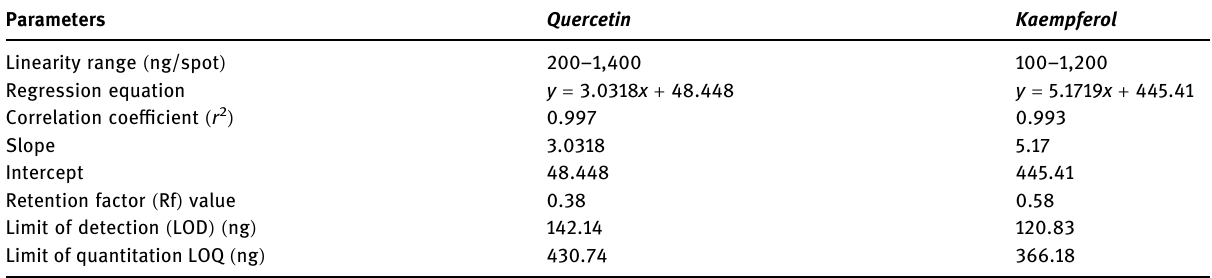
Table 4: Rf, linear regression data for the calibration curve of quercetin and kaempferol Parameters Linearity range ( ng/spot